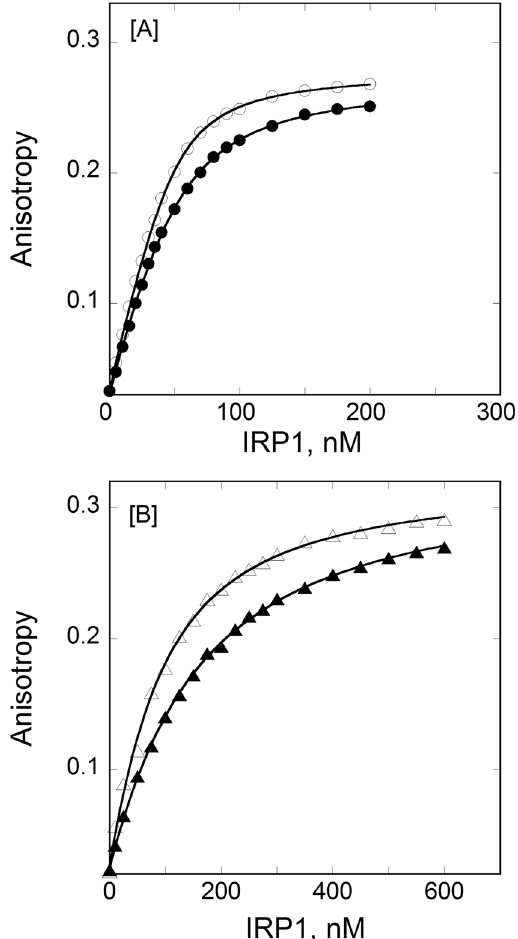
Figure 1. Temperature dependent binding plots for the interaction of IRP1 to IRE-RNA. Panel A , temperature affects the binding affinity of FRT IRE-RNA with IRP1 repressor protein. Anisotropy values of FRT IRE-RNA at 10 °C ( ‒○‒ ) and 25 °C ( –⦁‒ ) with IRP1 protein are shown. Panel B , temperature affects the binding affinity of ACO2 IRE RNA with IRP1 repressor protein. The anisotropy values of ACO2 IRE-RNA at 10 °C ( ‒∆‒ ) and 25 °C ( ‒ ▲ ‒ ) with IRP1 protein are shown. The fluorescein tag IRE-RNA concentration was 50 nM in titration buffer. The excitation and emission wavelength were 490 and 520 nm, respectively. The curves were fit to obtain dissociation constant ( K d ) as described in Experimental Procedure. The solid lines are the fitted curves.